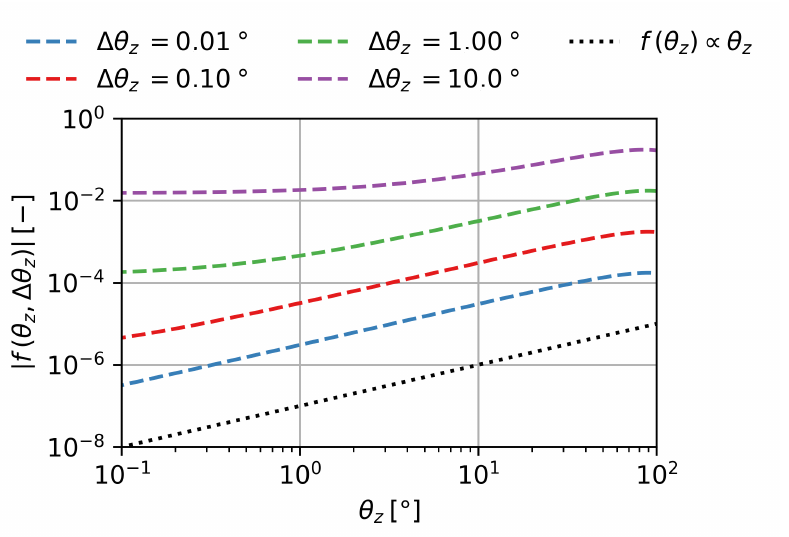
Figure 7. The subfunction f ( θ z , ∆ θ z ) = ( cos ( θ z + ∆ θ z ) − cos ( θ z )) for various ∆ θ z over θ z in double logarithmic scale.